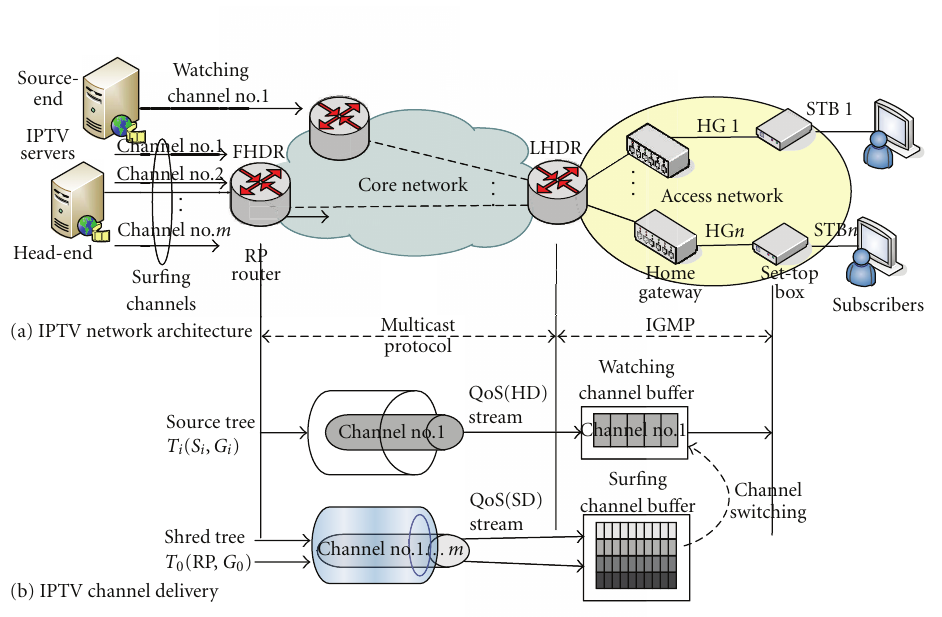
Figure 1: IPTV multicast network architecture consists of (a) core network and access network; IPTV channel delivered by (b) hybrid-tree based channel distribution